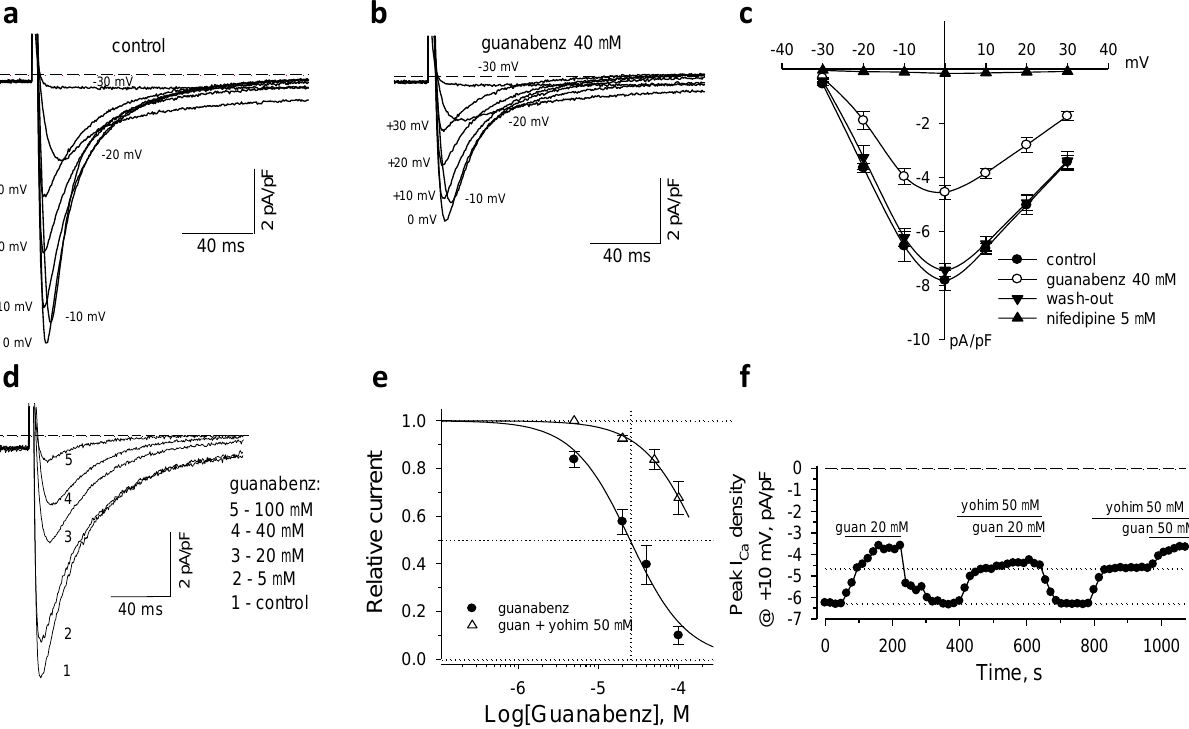
Figure 1. Guanabenz, an agonist of α 2-AR, suppressed L-type Ca 2+ currents ( I CaL ) in isolated mouse cardiac myocytes. ( a , b ) Whole-cell currents were measured in response to depolarization from − 40 mV to membrane potentials indicated nearby the current traces. ( c ) Voltage – current relationships demonstrated reversible guanabenz-induced inhibition of membrane currents that, under the experimental conditions, entirely belong to the dihydropyridine (nifedipine)-sensitive I CaL ( n = 3 – 5). ( d ) Representative dose-dependent suppression of I CaL by guanabenz. ( e ) Dose-dependent relationships of the guanabenz-induced suppression of I CaL constructed based on the peak I CaL values relative to the control peak I CaL . Yohimbine, a non- specific antagonist of α2 -AR isoforms, induced a rightward shift of the guanabenz-dependent dose effect. This relationship was constructed relative to the values measured in the presence of yohimbine alone. Curves represent the Hill’s fits with parameters indicated in the text. ( f ) Representative time-course of the peak I CaL density values in the presence of guanabenz (guan) and yohimbine (yohim). Horizontal bars denote the protocol of the drug applications.